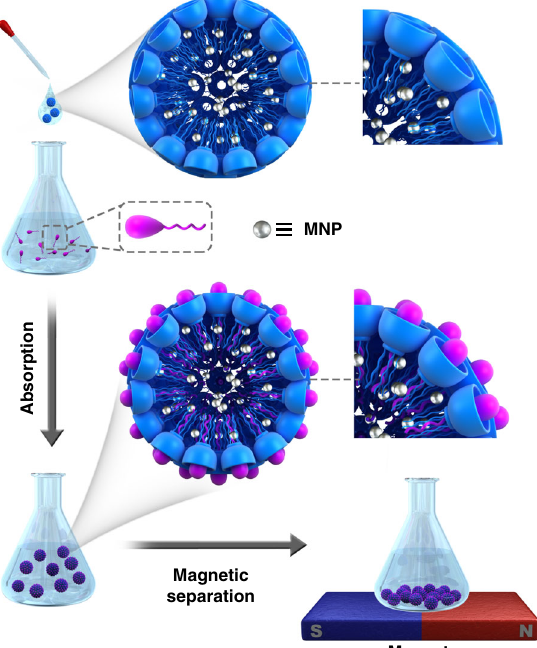
Fig. 7 Schematic illustration of PFOS and PFOA absorption and magnetic separation. Illustration of the absorption and magnetic separation procedure of PFOS and PFOA by the MNP@GC5A-12C